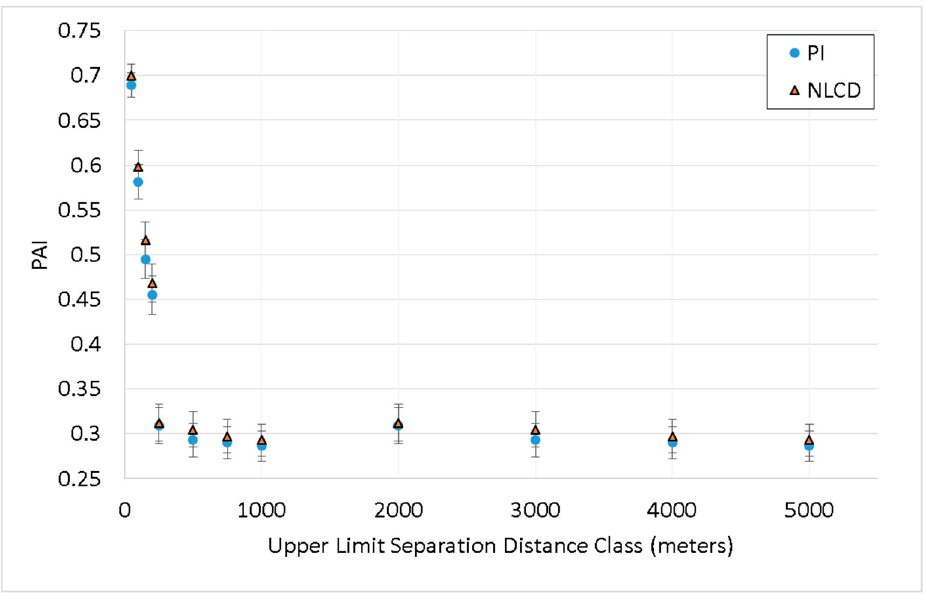
Figure 7. PAI vs. separation distance class for the PG study area, calculated with both photointerpreted (PI) and NLCD-based change maps. Error bars represent 95% confidence intervals.